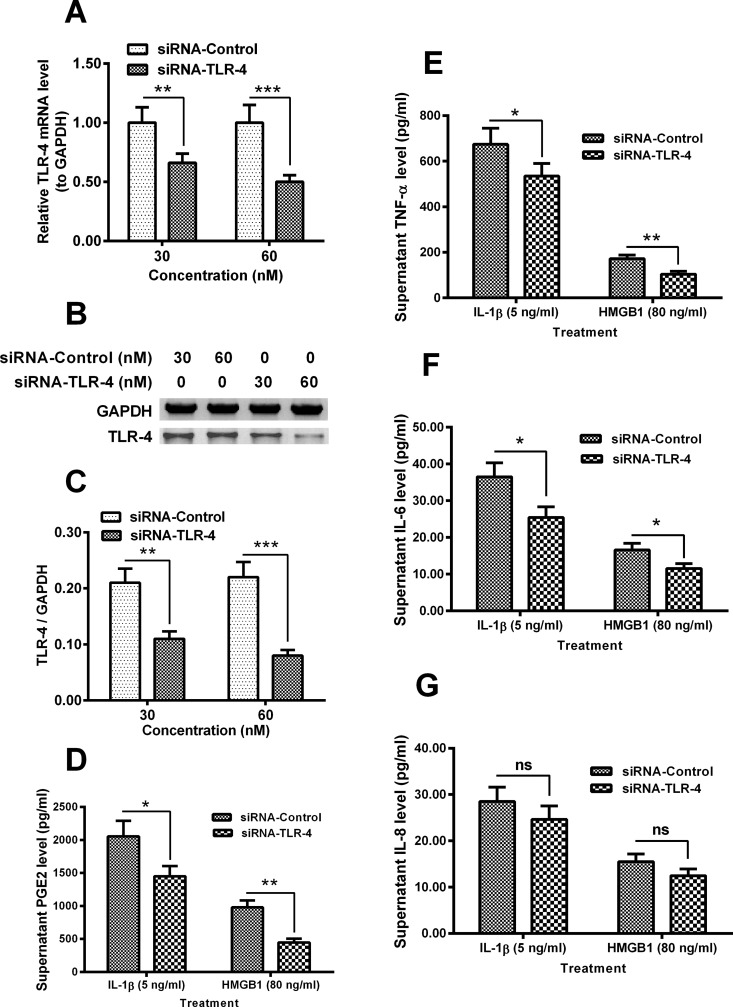
siRNA-mediated TLR-4 knockdown inhibited the IL-1β- and HMGB1-induced CK release(A) TLR-4 mRNA level in the disc annulus fibrosus cells, which were transfected with 30 or 60 nM siRNA-Control or siRNA-TLR-4 for 24 h; (B and C) Western blot analysis of TLR-4 in protein level in the siRNA-Control- or siRNA-TLR-4-transfected disc annulus fibrosus cells for 24 h; (D–G) Supernatant levels of PGE2 (D), TNF-α (E), IL-6 (F) or IL-8 (G) in the IL-1β- (5 ng/ml for 24 h) or HMGB1- (80 ng/ml for 24 h) treated disc annulus fibrosus cells. Results are presented as mean ± S.E.M. for quartic independent experiments. P values were calculated by Student t test between two groups, post the ANOVA test for the homogeneity of variance. *P<0.05, **P<0.01 or ns: no significance.